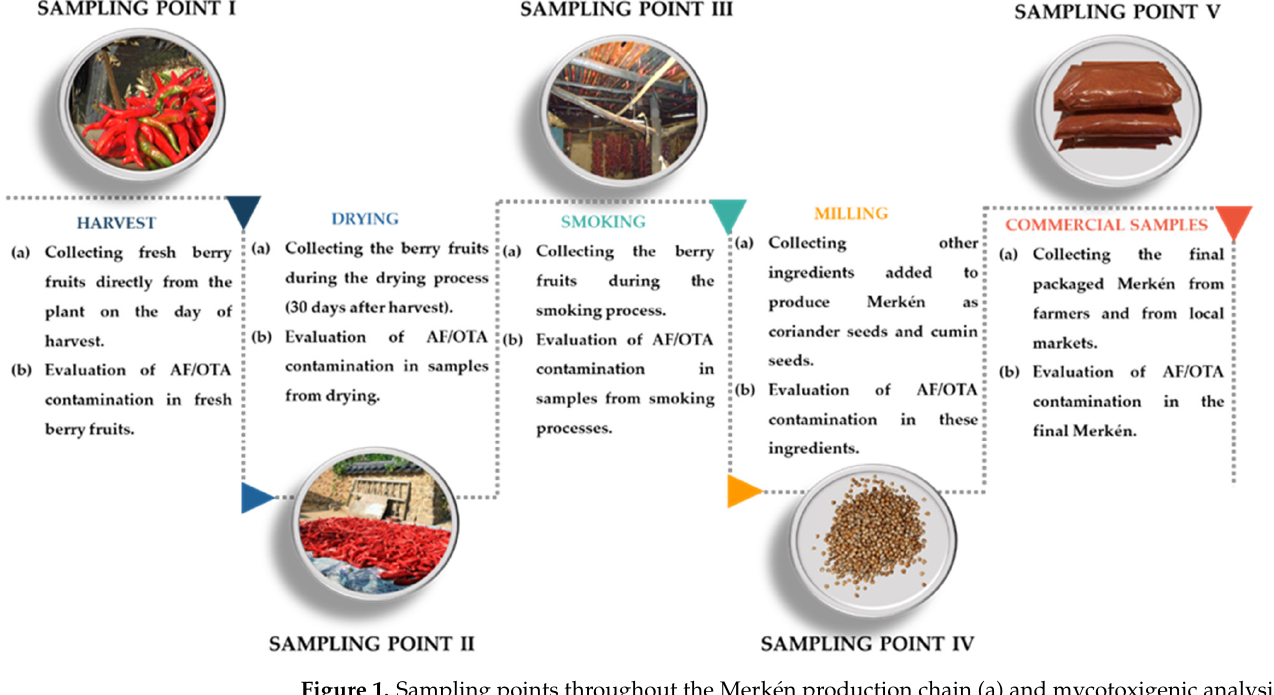
Figure 1. Sampling points throughout the Merkén production chain ( a ) and mycotoxigenic analysis carried out on samples from each stage ( b